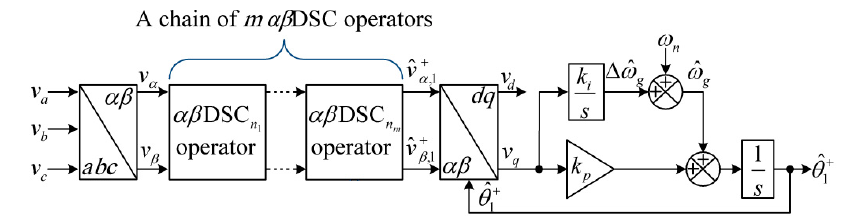
Figure 4. The common block diagram of using delay signal cancellation (DSC)s in PLL.